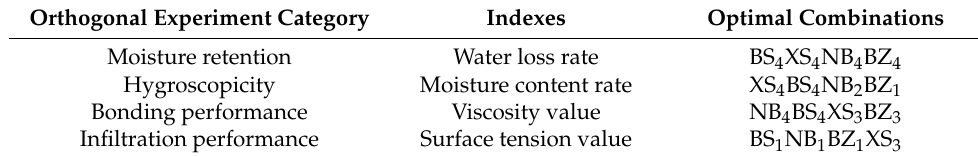
Figure 4. ( a – d ) Influence trend of factor levels on water loss rate, moisture content rate, viscosity value, and surface tension, respectively. Table 4. Optimal combinations of orthogonal experiment.